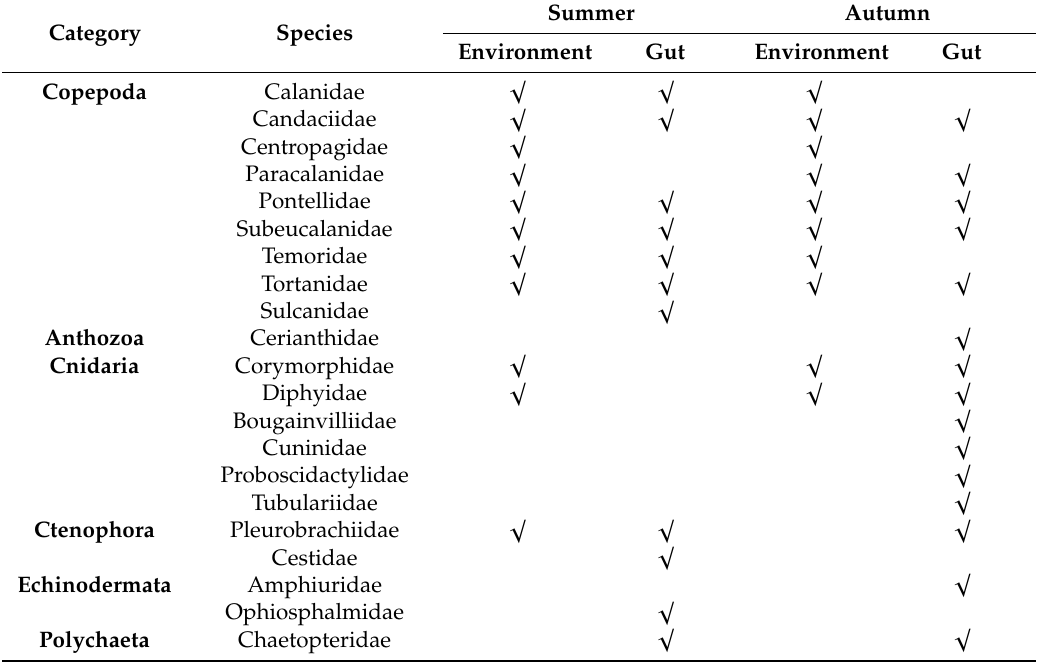
Table A3. Family of taxa genetically explored in the gut contents compared to the ambient zooplankton